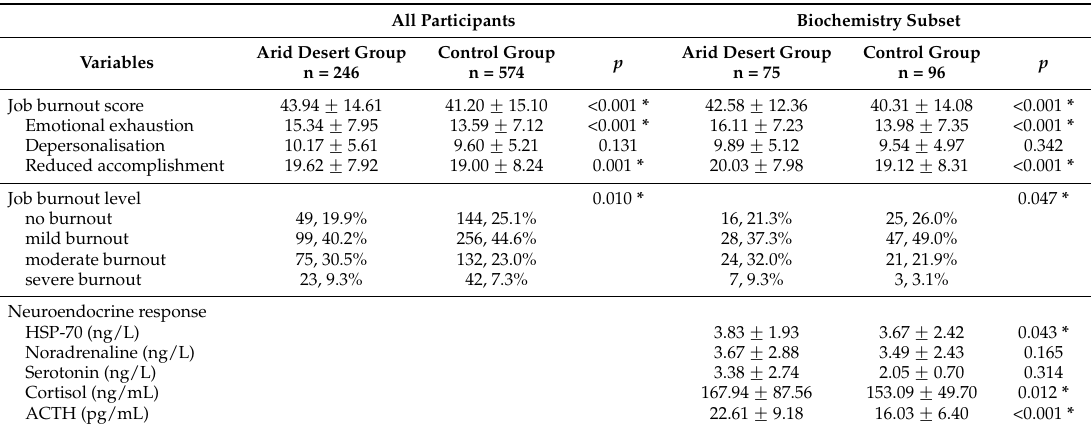
Table 2. Results of burnout and neuroendocrine